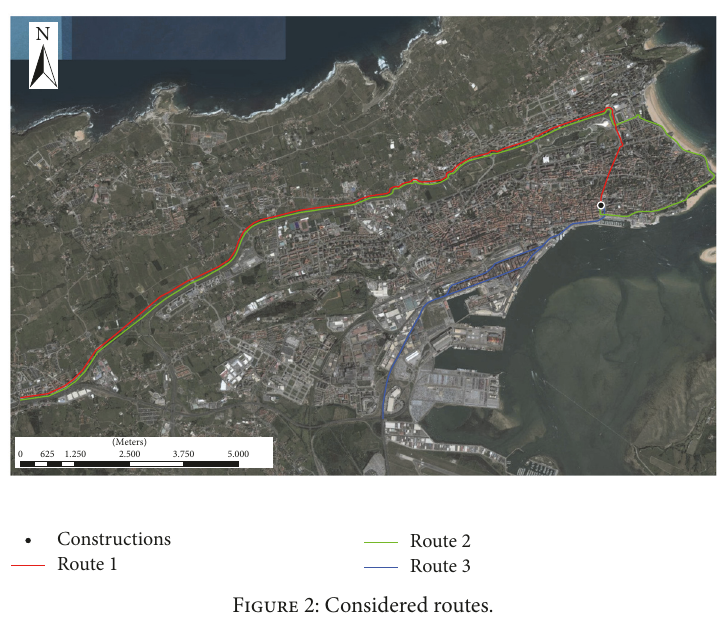
Figure 2: Considered routes. Table 1: Vehicle’s consumption rates (litres/Km) and vehicle’s emission rates (g of pollutant/Kg of fuel) [26, 27]. Emissions (g of pollutant/Kg of fuel)